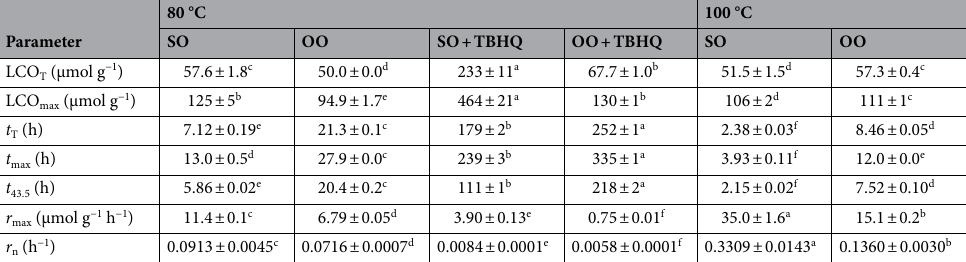
Table 2. The parameters resulting from the sigmoidal equation fitted on the kinetic curves of the accumulation of lipid-peroxidation carbonyls (LCO) during oxidation of the sunflower (SO) and olive (OO) oils in the presence and absence of tert -butylhydroquinone (TBHQ) at 80 and 100 °C. Means ± SD (standard deviation) within a row with the same lowercase letters are not significantly different at P < 0.05. LCO T LCO concentration at the turning point of the sigmoidal equation; LCO max The maximum concentration of LCO attained during the course of lipid peroxidation; t T The time required to reach LCO T ; t max The time required to reach LCO max ; t 43.5 The time required to reach a LCO content of 43.5 μmol g −1 ; r max Maximum rate of LCO accumulation; r n Normalized r max